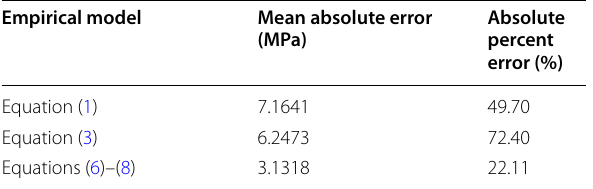
Table 4 Comparisons of the existing and the modified equations for average strength Empirical model Mean absolute error